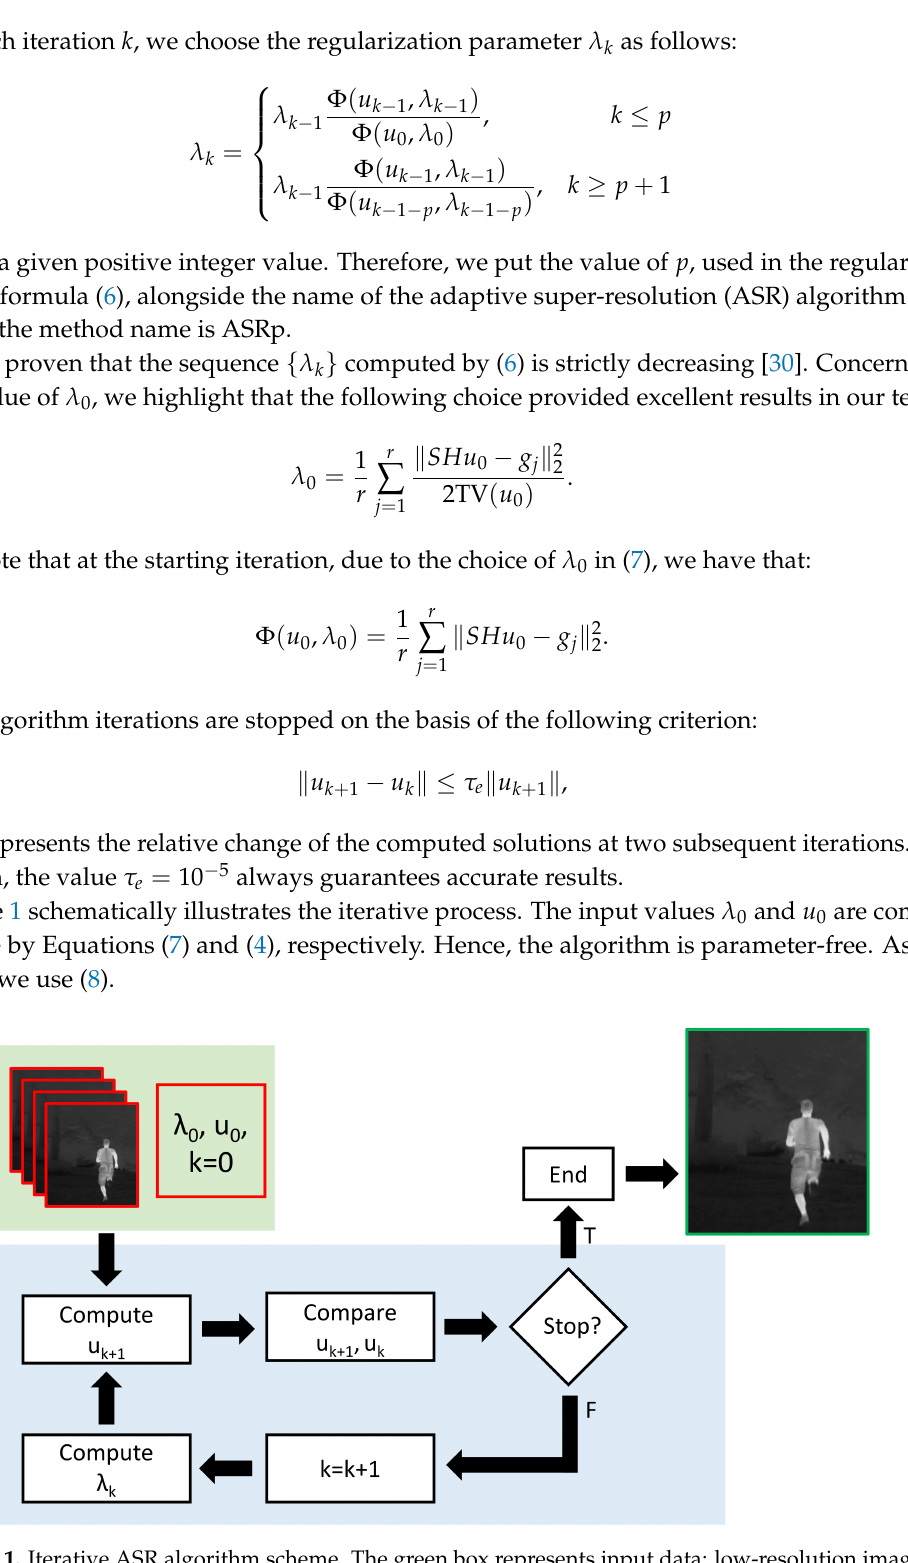
Figure 1. Iterative ASR algorithm scheme. The green box represents input data: low-resolution images and starting guesses u 0 (4) and λ 0 (7). The blue box represents the iterative steps, where u k + 1 is computed by Equations(1) and λ k is given by (6). Finally, the iterative process ends when the stopping condition (8) is true, then the output of the algorithm is reported in the green